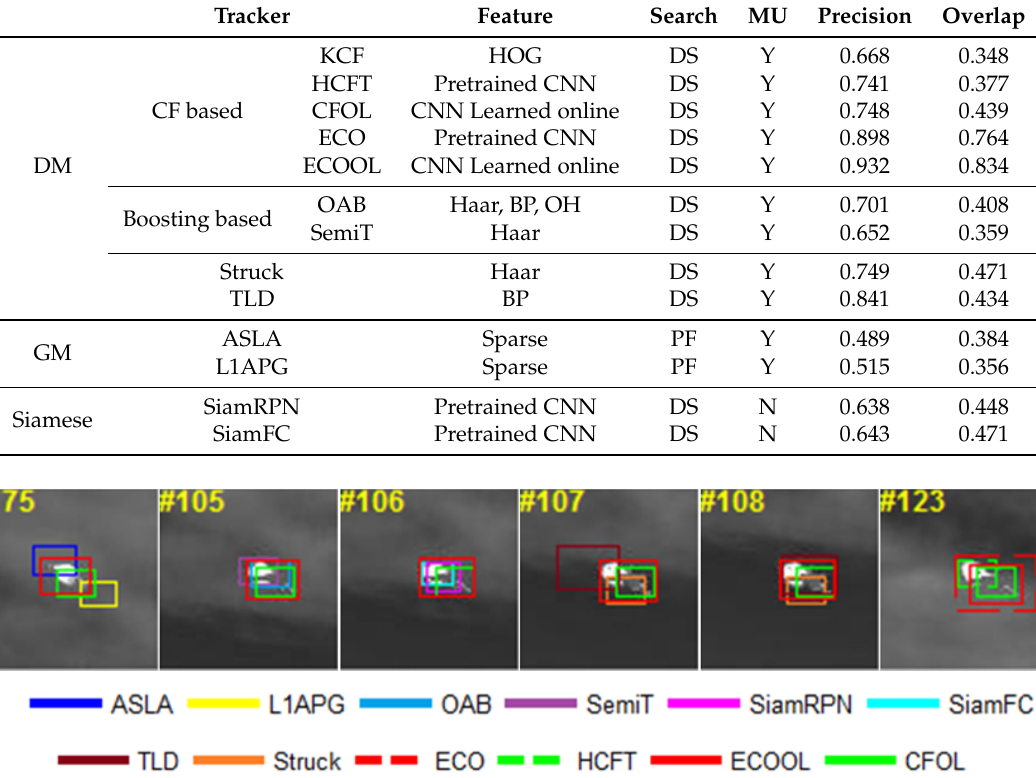
Figure 14. Qualitative comparisons of the tracking